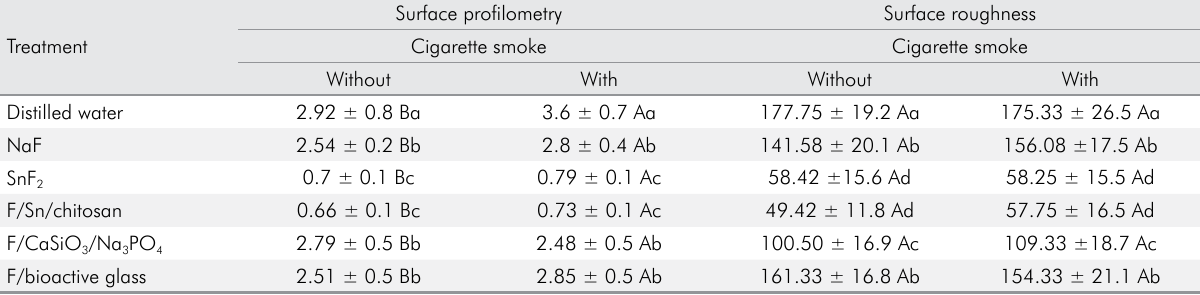
Table 3. Results (mean ± standard deviation) of tissue loss ( μ m) and surface roughness (nm) based on treatment with toothpastes and exposure to cigarette